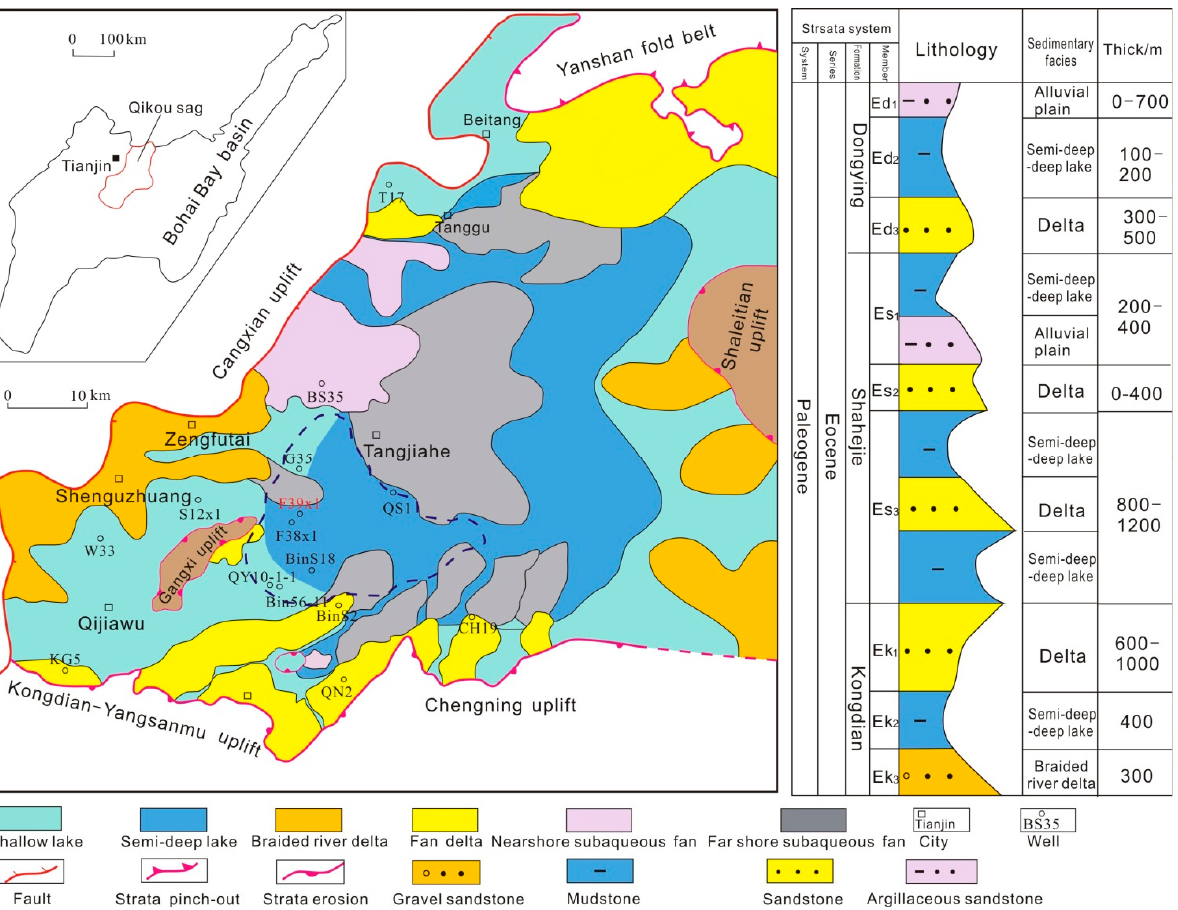
Figure 1. Plane distribution of sedimentary facies ( left ) and stratigraphic column ( right ) of the upper part of Es3 in Qibei slope, Qikou Sag, Bohai Bay basin (modified from document [21]). Shale oil exploration of the Shahejie Formation in the Qikou Sag started in